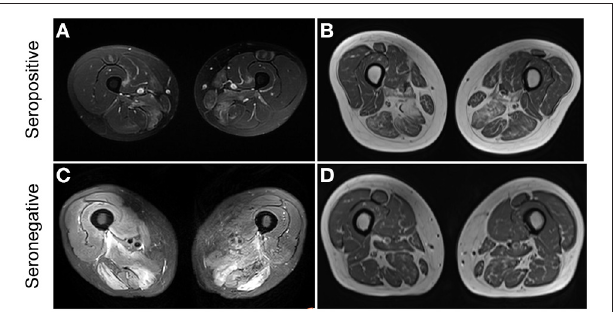
FIGURE 2 | Representative thigh muscle MRI of seropositive and seronegative immune-mediated necrotizing myopathy (IMNM). (A) High signal intensity on MRI STIR images in a patient with seropositive IMNM. (B) Muscle atrophy and fatty replacement on MRI T1 images in a patient with seropositive IMNM. (C) Diffuse increased signals on MRI T2 images in a patient with seronegative IMNM. (D) Muscle atrophy and fatty replacement on MRI T1 images in a patient with seronegative IMNM.